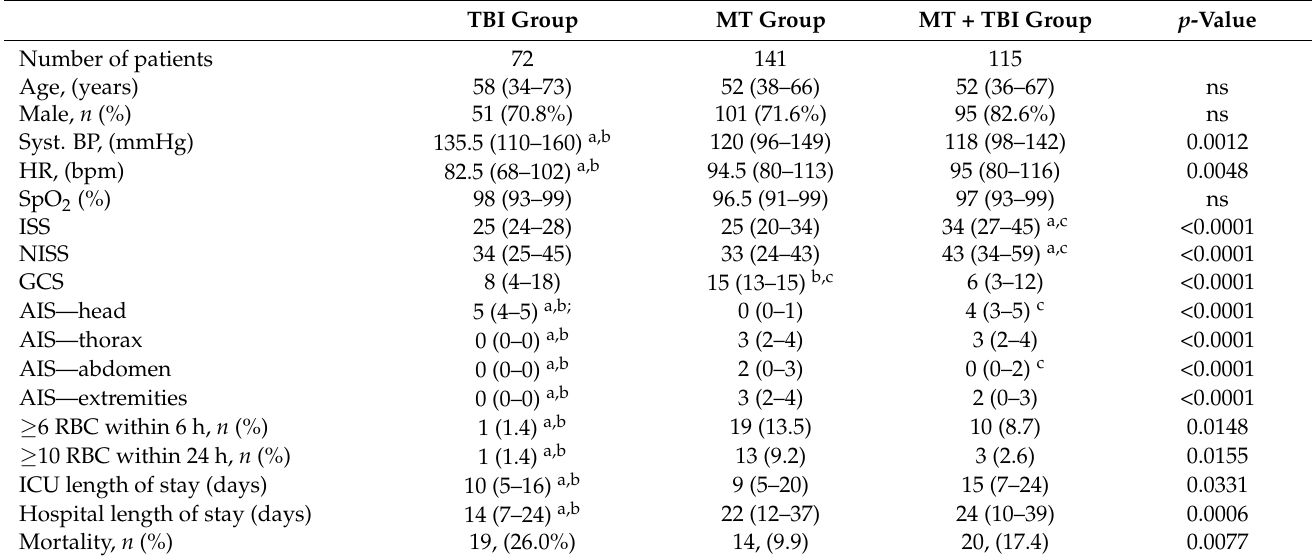
Table 1. Demographics, clinical data, and injury scores upon emergency room admission.